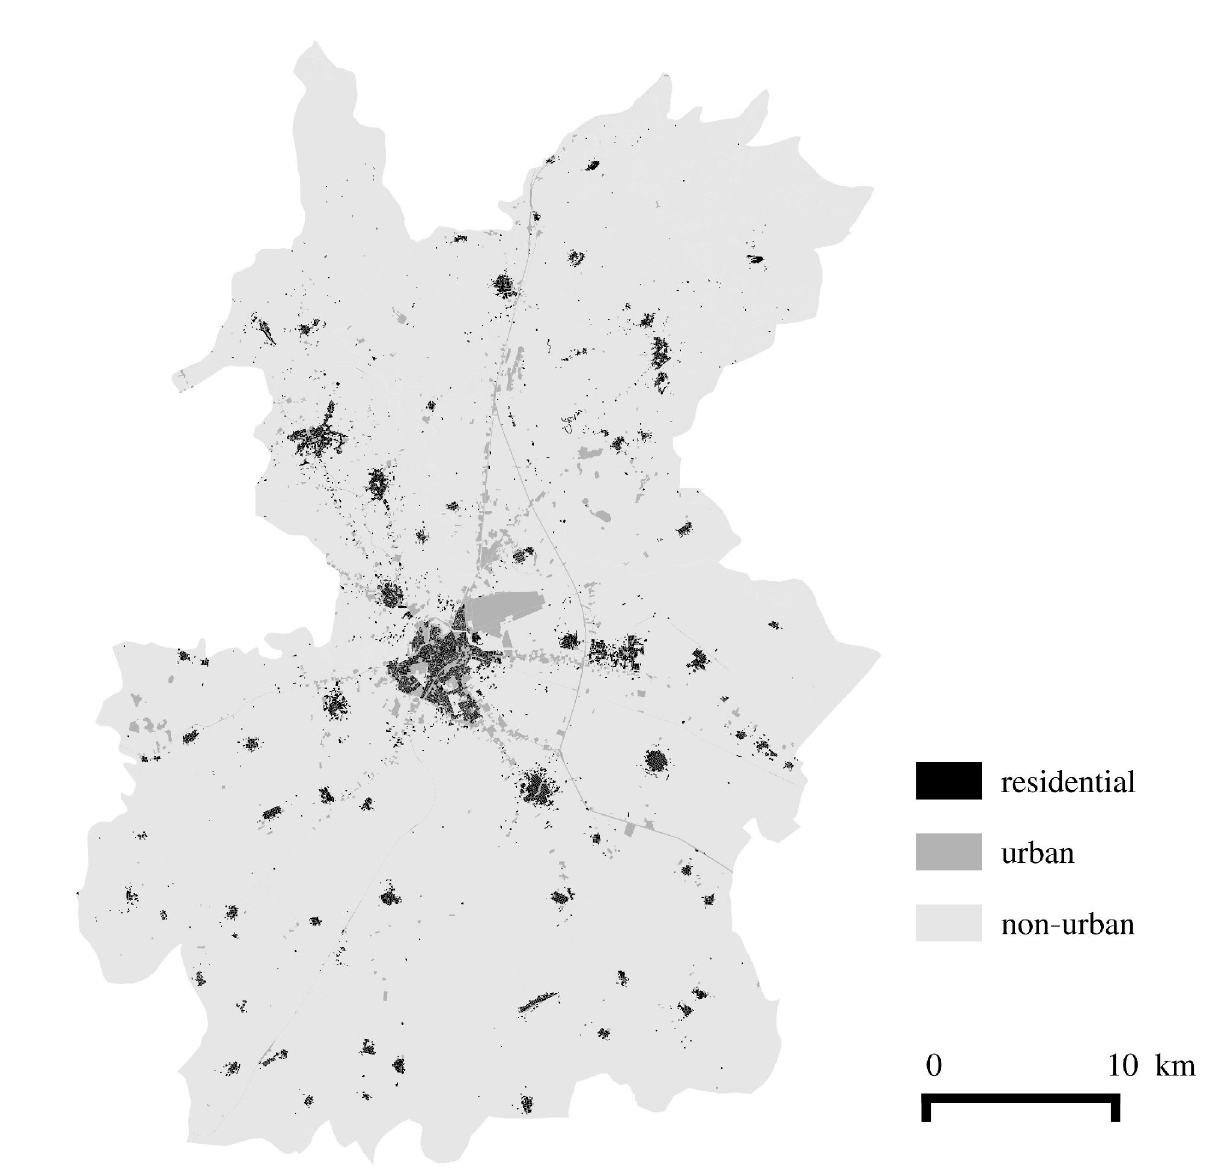
Figure 2. Urban Atlas data for the city of Larisa (gr005l_larisa).